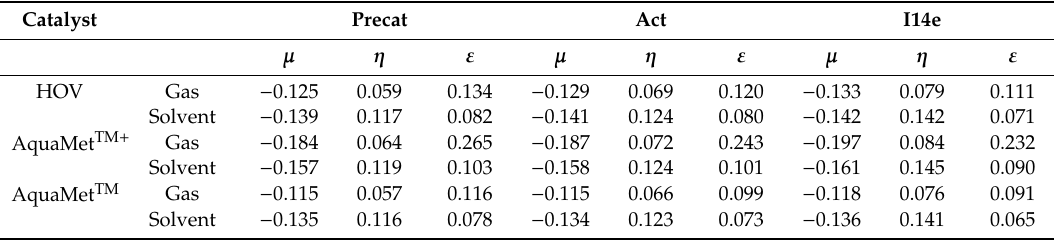
Table 3. Conceptual density functional theory (DFT) analysis ( µ = chemical potential, η = chemical hardness, ε = Parr electrophicity; in a.u.) for Precat, Act and I14e.